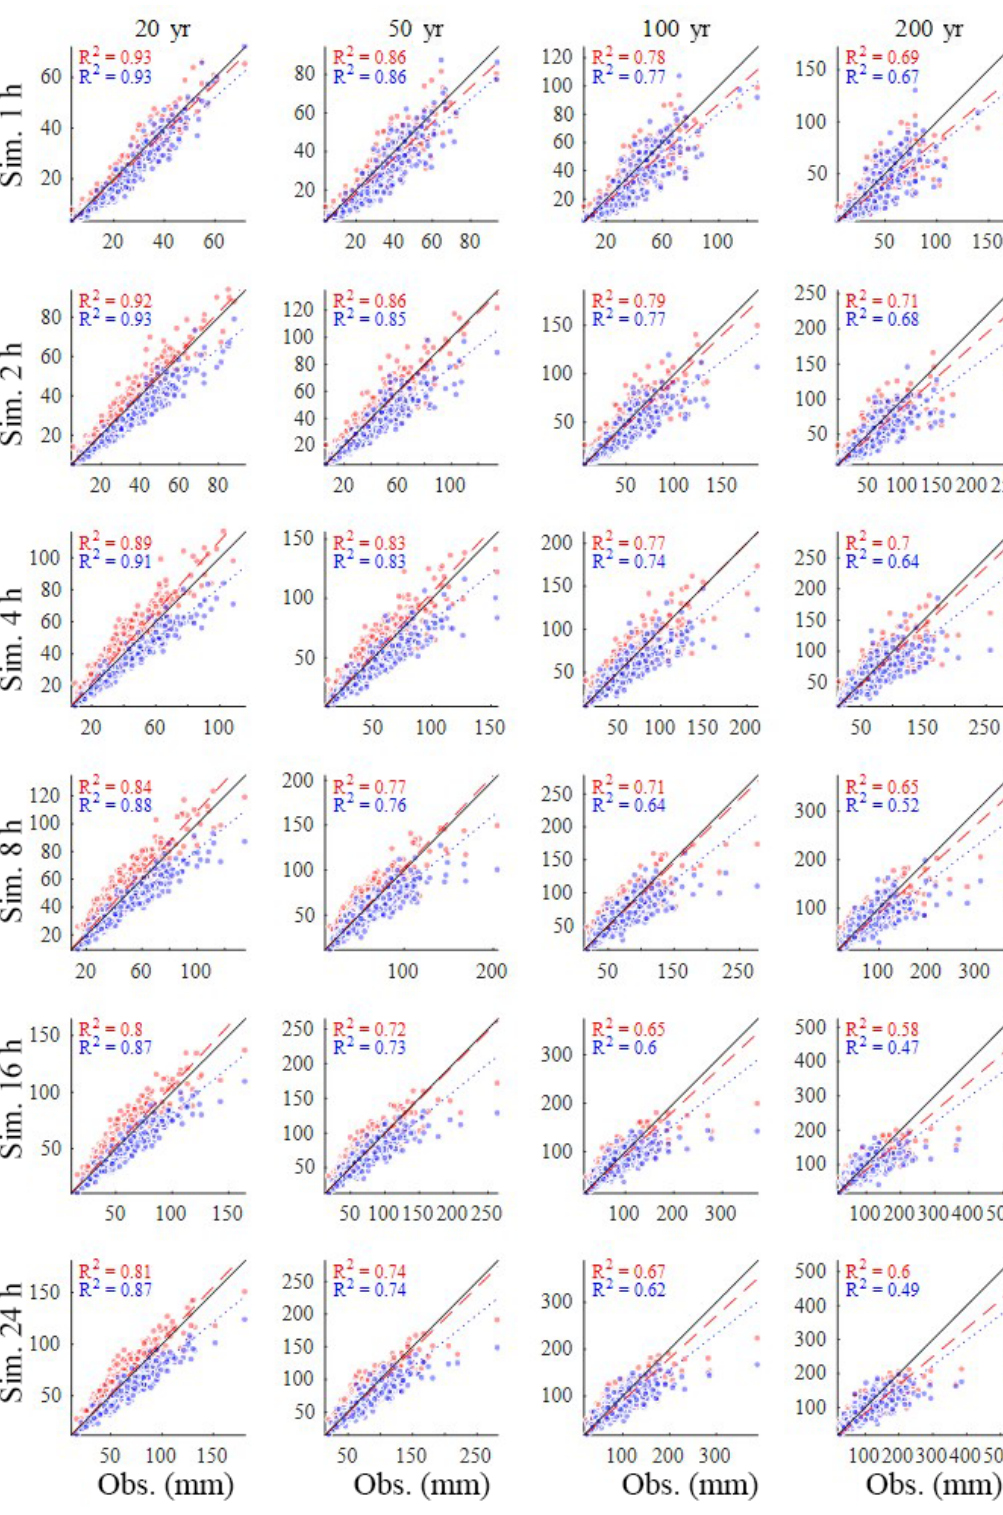
Figure 13. Comparison of the extreme rainfall values estimated from the observed rainfall ( x ) and synthetic rainfall ( y ) generated by the model of this study (red) and the MBLRP model (blue). The plots compare 20, 50, 100, and 200 year rainfall at hourly to daily aggregation